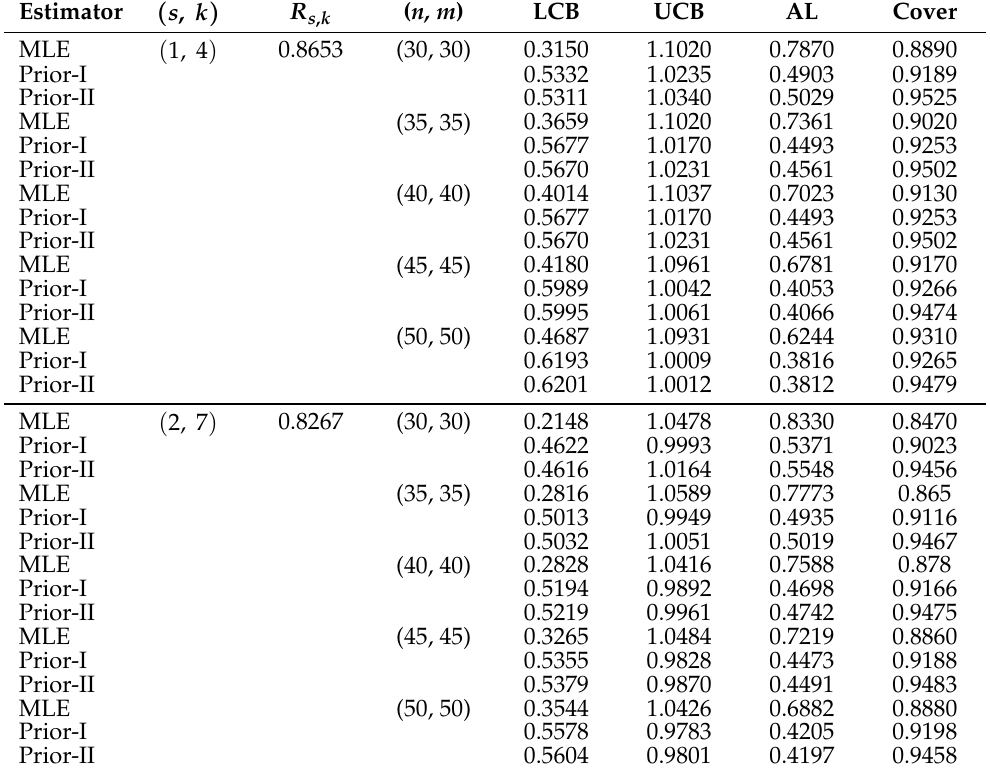
Table 9. The 95% confidence intervals of R s , k for Case 2, ( α , λ 1 , β , λ 2 ) = ( 1.5, 1, 2, 1 ) , and T =